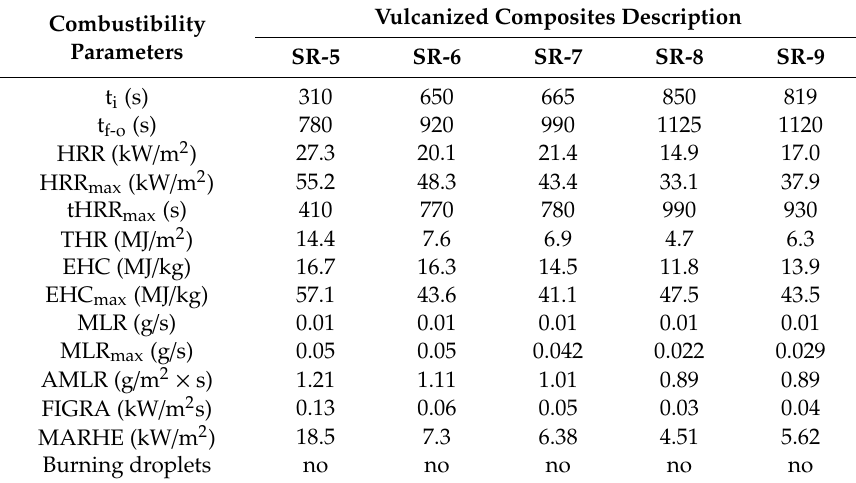
Figure 8. Remains after burning of the composites ( A ) SR-0, ( B ) SR-3 followed by removing the outer layer, and ( C ) SR-4 followed by removing the outer layer. Table 6. Flammability of ceramizable